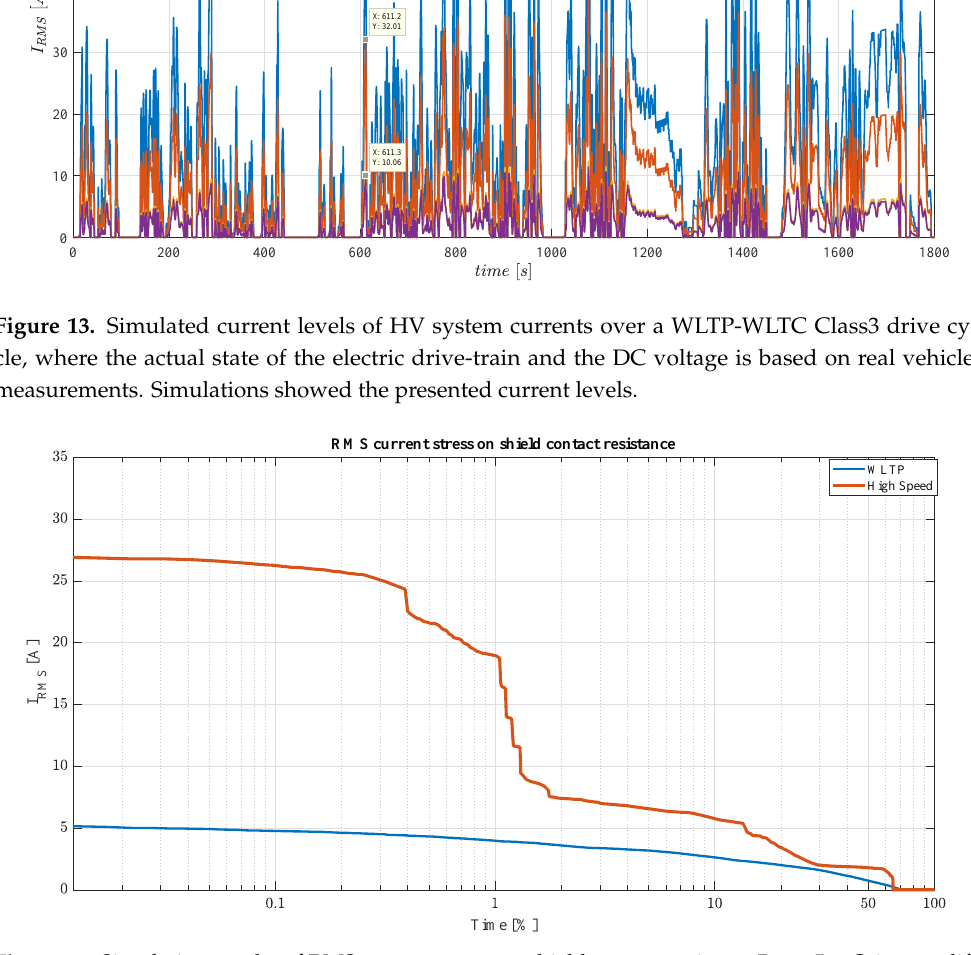
Figure 14. Simulation results of RMS current stress on shield contact resistors R ue = 5 m Ω in two dif- ferent drive cycles. The results estimate the frequency of limit violations in different driving